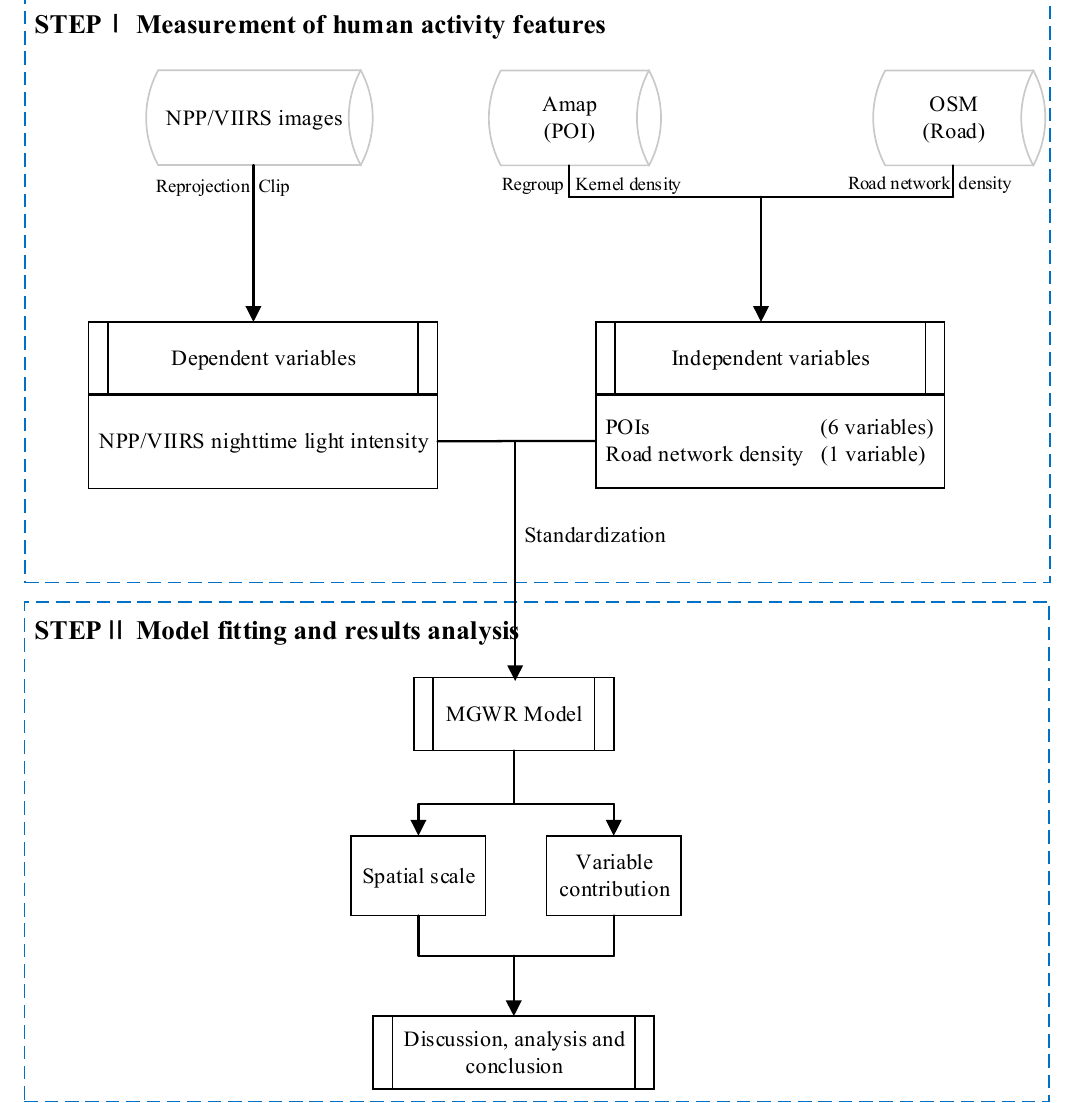
Figure 3. The overall framework of the